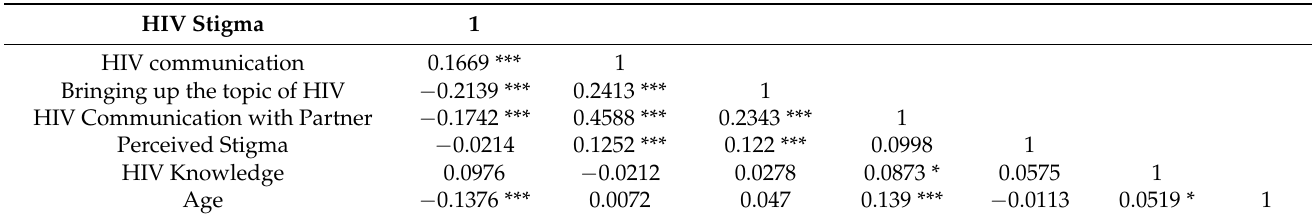
Table 2. Bivariate correlations of study continuous variables on HIV stigma (N = 1437).